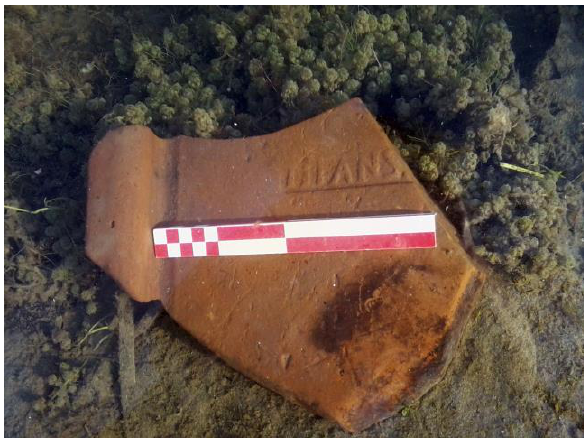
Figure 14. Fragment of Tiberi Pansiana tile from Tramonto